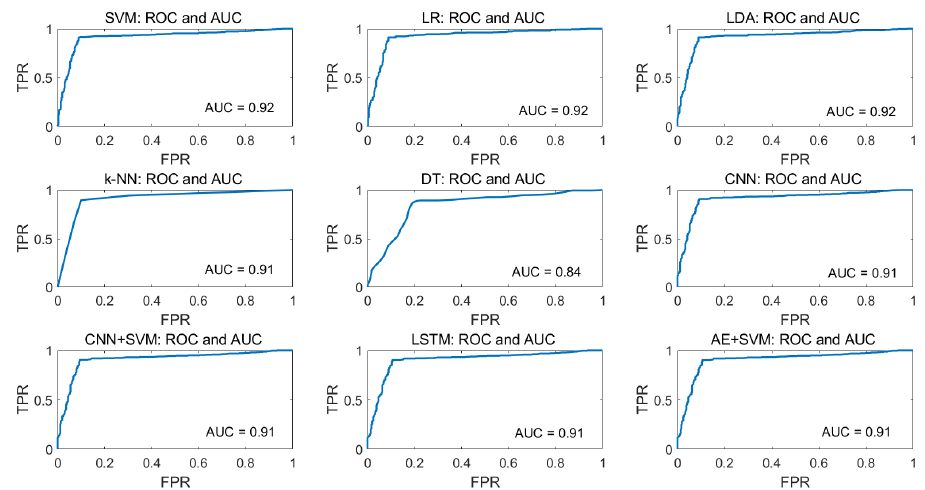
Figure 18. ROC and AUC for ML classifiers considering camera system.